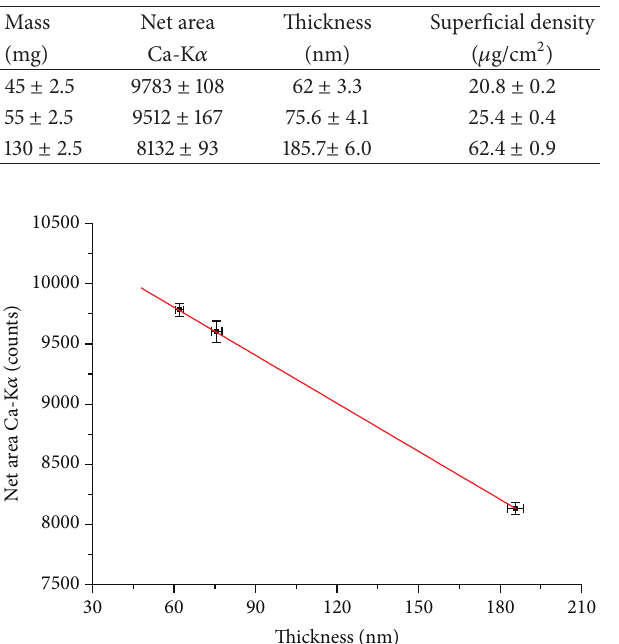
Table 4: Thickness of unknown samples of the vanadium films calculated.